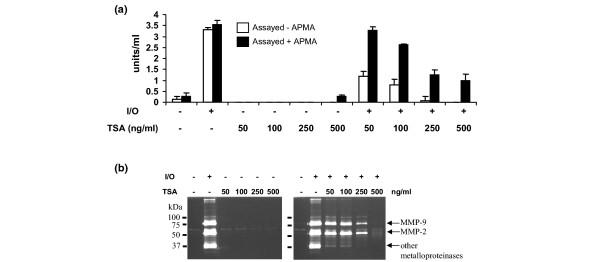
HDAC inhibitors decrease collagenolytic and gelatinolytic activity from bovine nasal explants and block collagenase activation. Conditioned media from cartilage assays (day 14) as in Fig. 1a were assayed (a) for collagenase activity in the presence or absence of 0.67 mM APMA, an activator of procollagenases (means ± standard errors of the mean), and (b) for gelatinase activity, using gelatin zymography. APMA, aminophenylmercuric acetate; HDAC, histone deacetylase; I/O, a combination of IL-1α and OSM; MMP, matrix metalloproteinase; OSM, oncostatin M; TSA, trichostatin A.